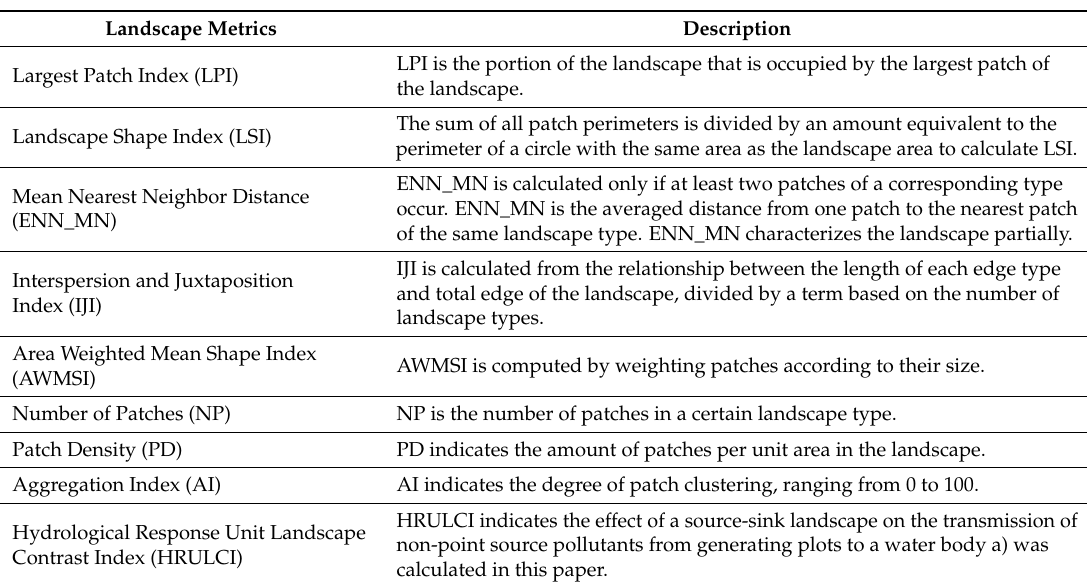
Table 2. Introduction of landscape metrics.